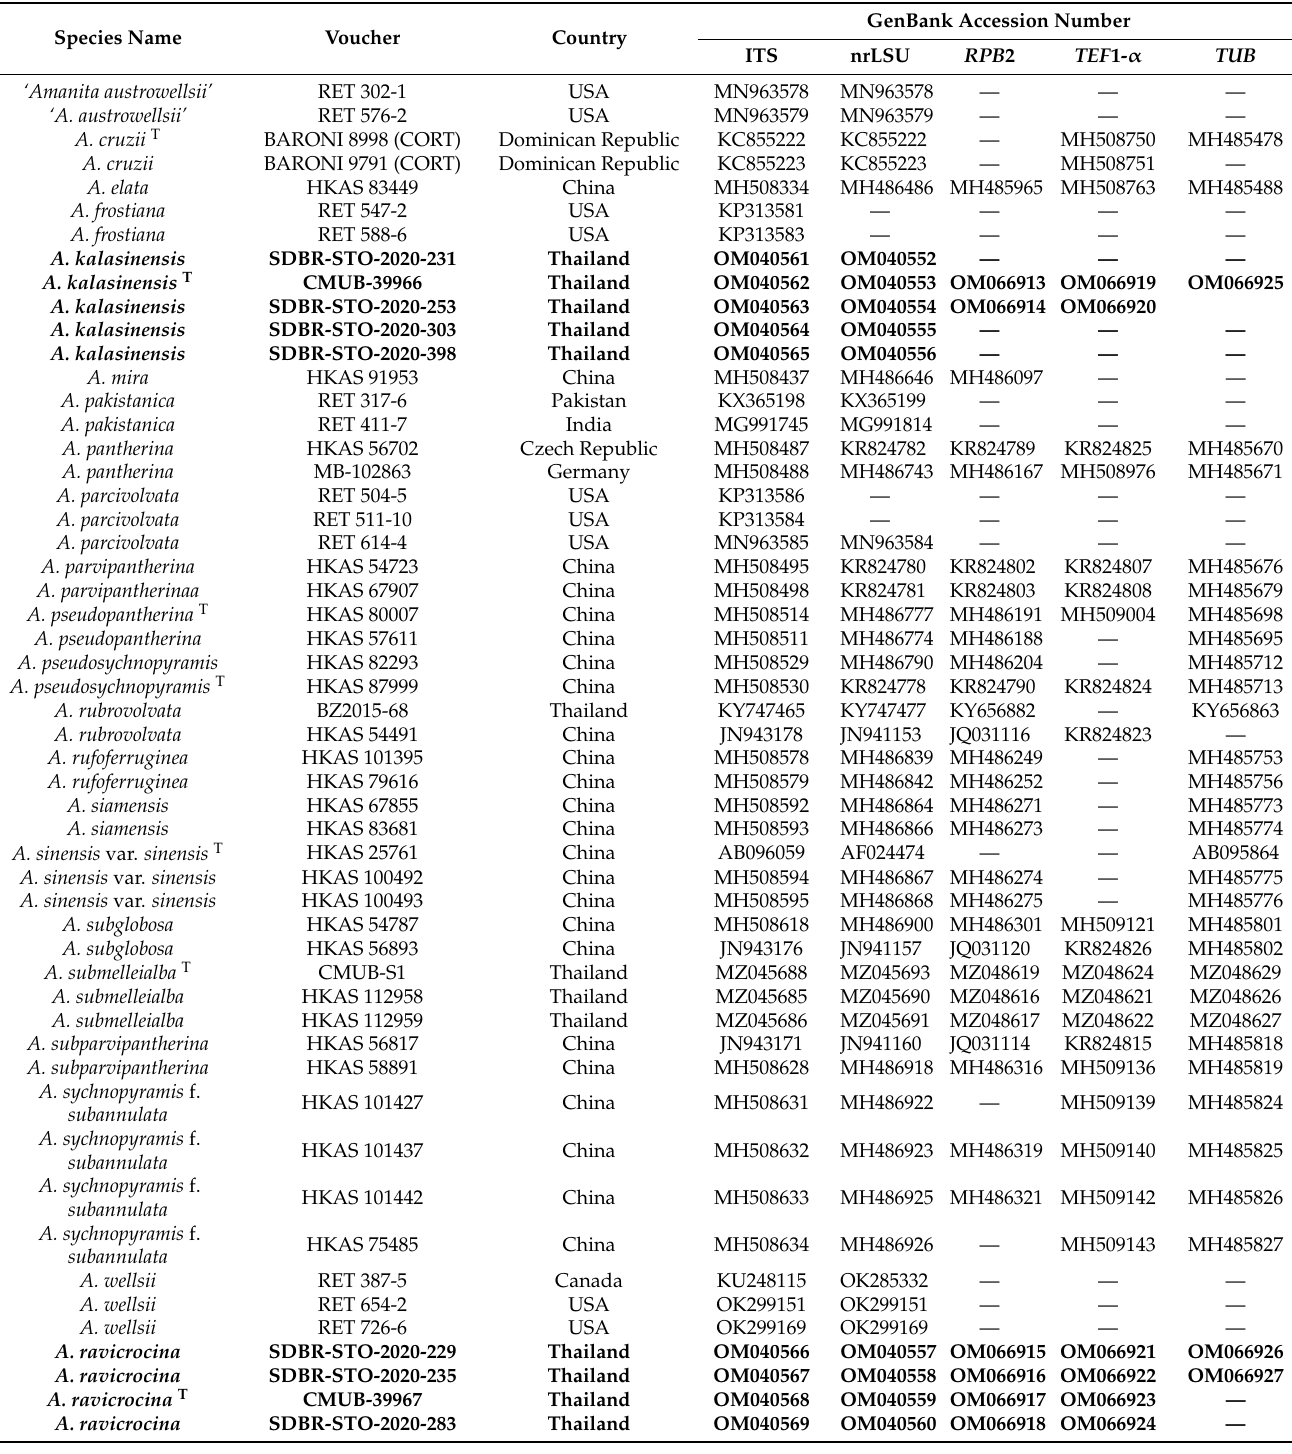
Table 1. Species names, voucher numbers, countries, and their respective GenBank accession numbers of the taxa used in this